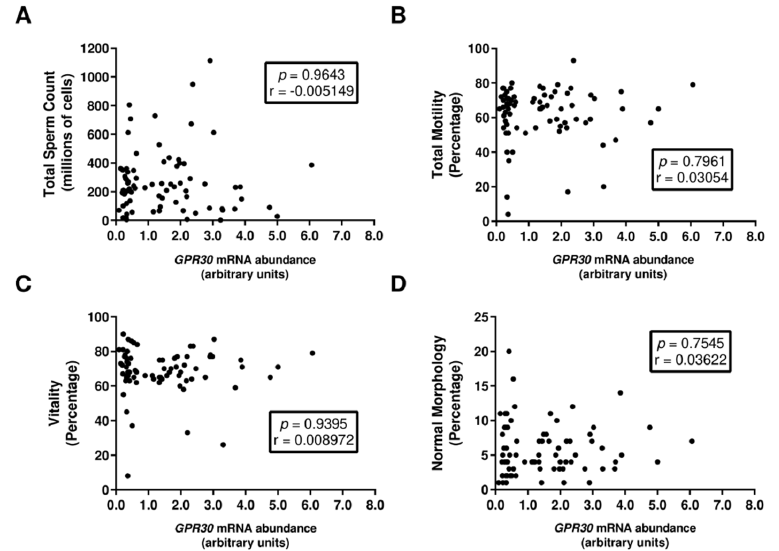
Figure 1. Association of GPR30 mRNA expression with sperm parameters. The figure shows the distribution of the GPR30 mRNA abundance of spermatozoa with classic sperm parameters, including total sperm count, n = 78 ( A ), total motility, n = 74 ( B ), vitality, n = 71 ( C ), and normal morphology, n = 74 ( D ). Sperm parameter data were collected from 81 patients with an average age of 39.7 years (age range 27–58 years) and different BMI values (weight range 19.4–33.8 kg/m 2 ). The relationship between GPR30 mRNA abundance and the different sperm parameters was evaluated by computing the Pearson correlation coefficients (r), assuming a Gaussian distribution (confidence interval of 95%). No correlations between the studied parameters were found to be statistically significant.